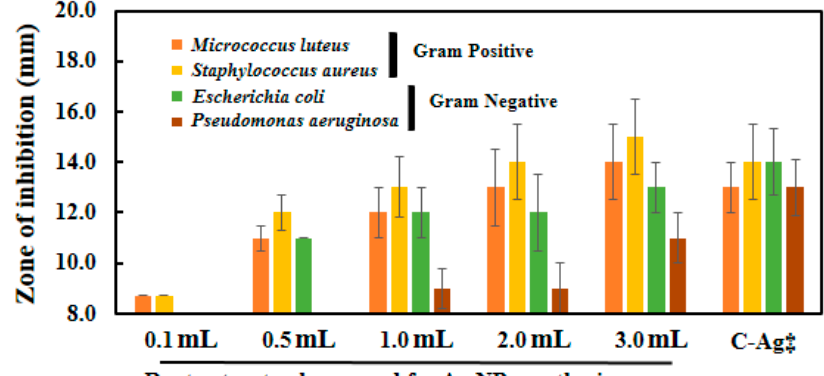
Figure 11. Antimicrobial activity of Ag-NPs against Gram-positive and Gram-negative bacteria as determined by Kirby-Bauer assay. Antimicrobial activity of the SP-Ag-NPs (100 µg/well) is also compared with C-Ag-NPs‡. The S. persica L. RE do not show any antimicrobial activity at the highest concentration used for the synthesis of Ag-NPs (i.e., 300 µg/mL).